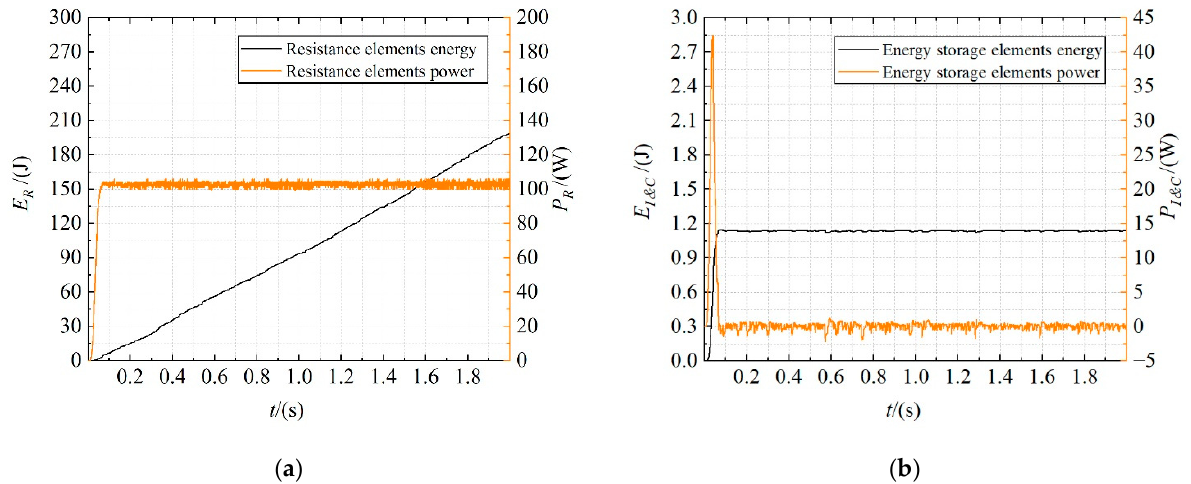
Figure 19. ( a ) The energy and power curve of the resistance elements; ( b ) the energy and power